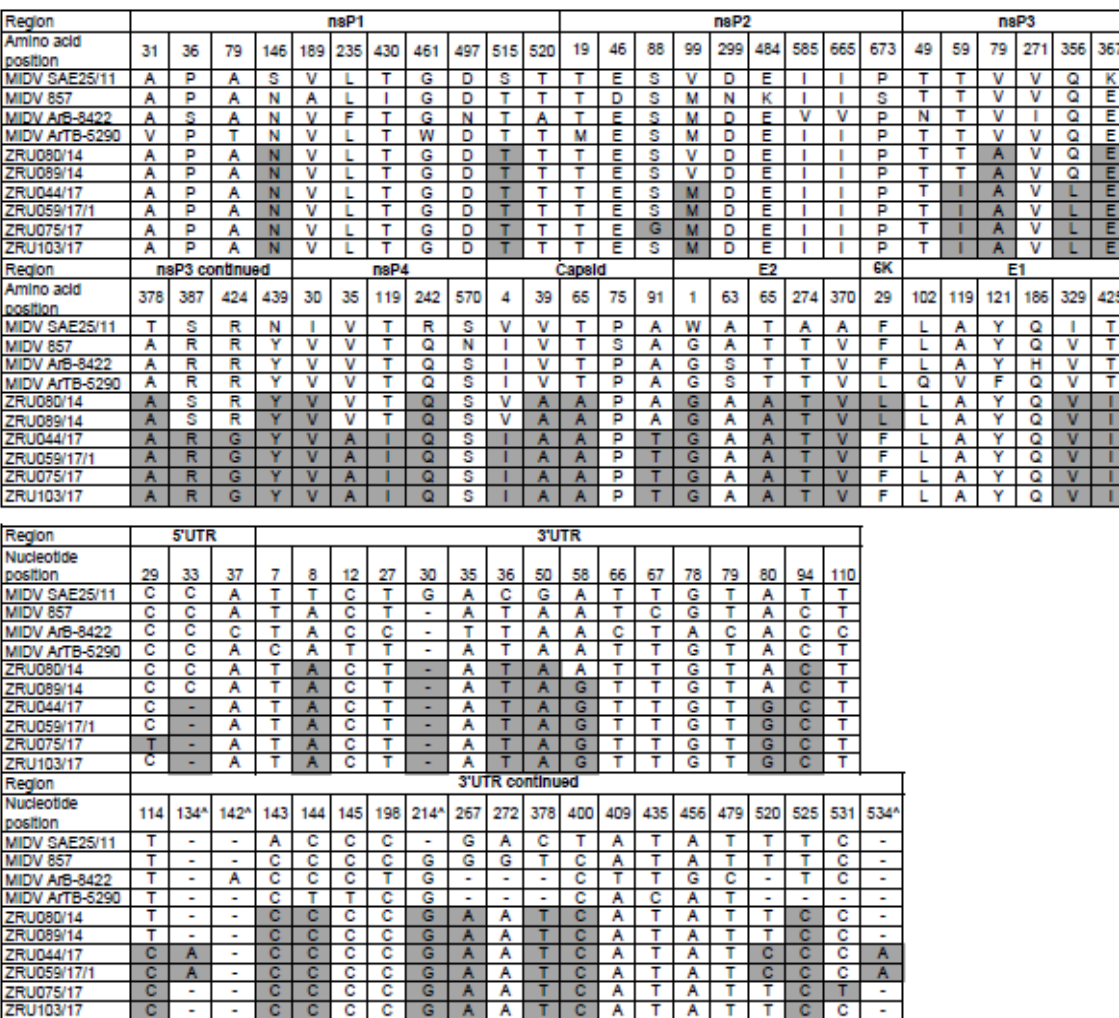
(ZRU080/14; ZRU089/14; ZRU044/17; ZRU059/17/1; ZRU075/17 and ZRU103/17) within the struc-